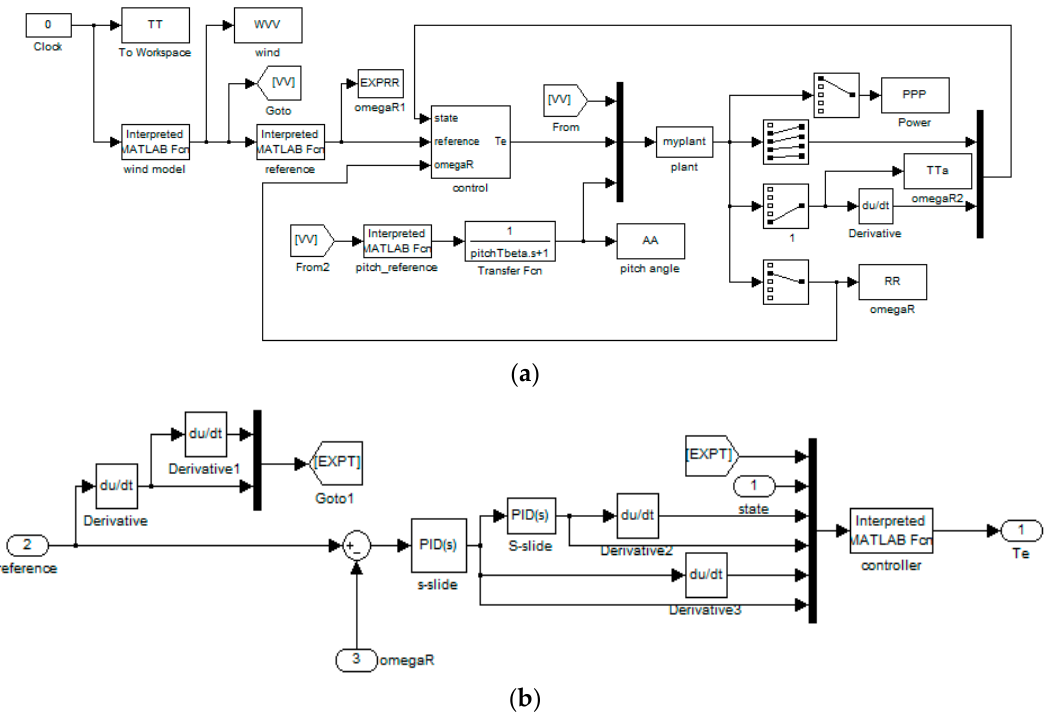
Figure 4. Second order sliding mode simulation model using MATLAB/SIMULINK. ( a ) Simulation diagram; ( b ) Simulation diagram.